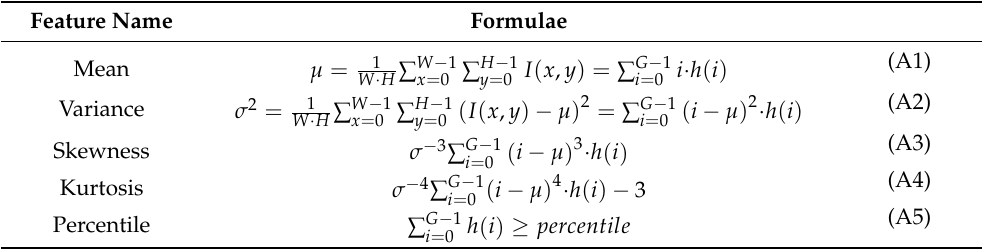
Table A1. Formulae to calculate first order features from the gray-scale